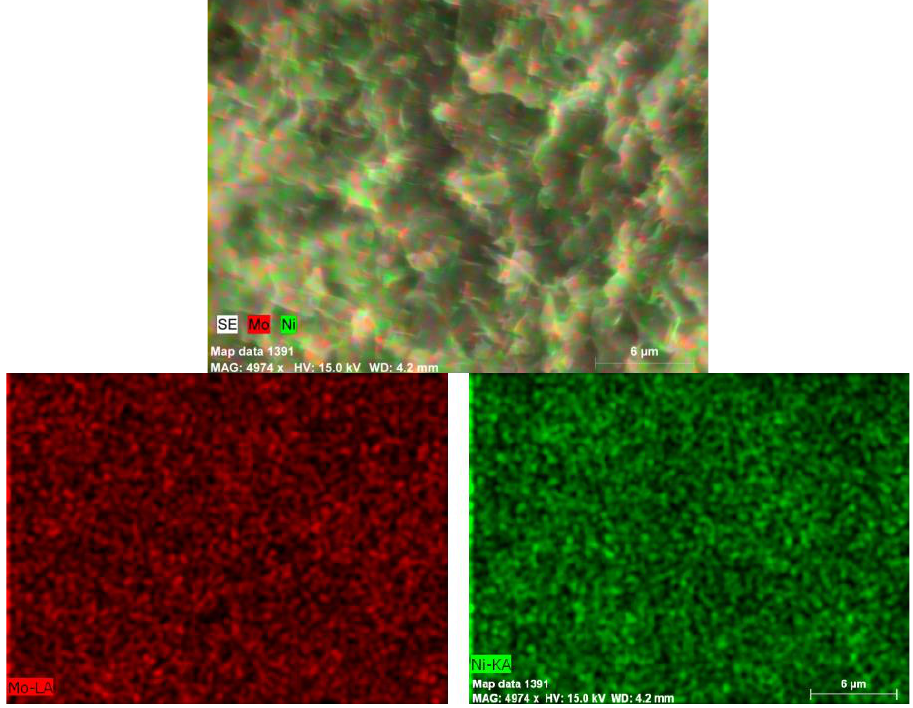
Figure 8. SEM – EDX maps of nickel and molybdenum in the sample